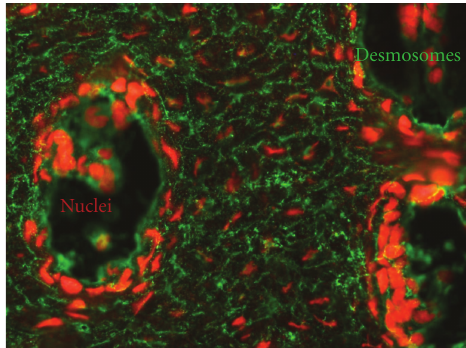
Figure 3: Double fluorescence assay using cow nose tissue. Cellular junctions were tagged in green (FITC) with labelled antiepithelial antibodies, and nuclei were tagged in red with labelled antinuclear antibodies (Texas